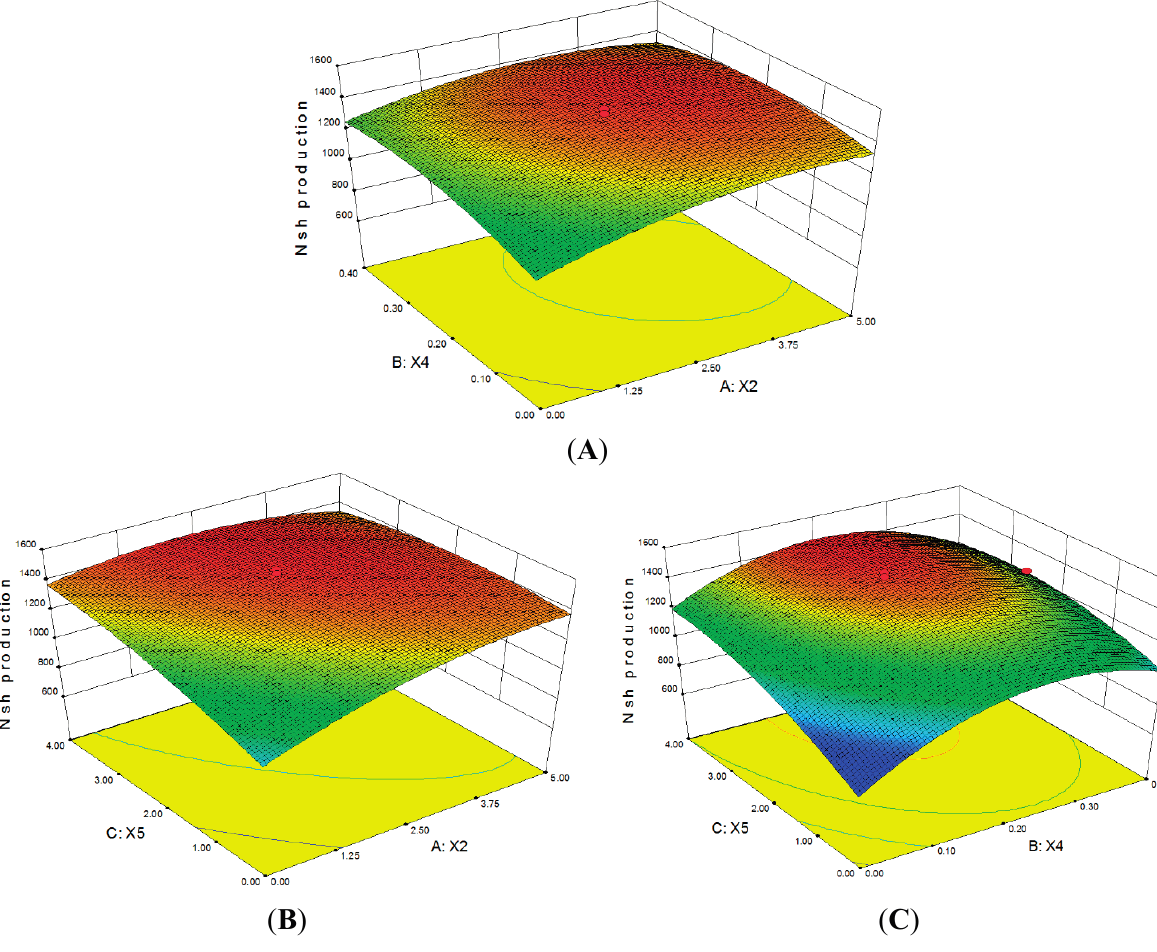
Figure 2. Three-dimensional (3D) response surface plots for dependent variables as a function of ( A ) Na 2 SO 4 (X 2 ) and MnSO 4 ·H 2 O (X 4 ); ( B ) Na 2 SO 4 (X 2 ) and MgSO 4 ·7H 2 O (X 5 ); and ( C ) MnSO 4 ·H 2 O (X 4 ) and MgSO 4 ·7H 2 O (X 5